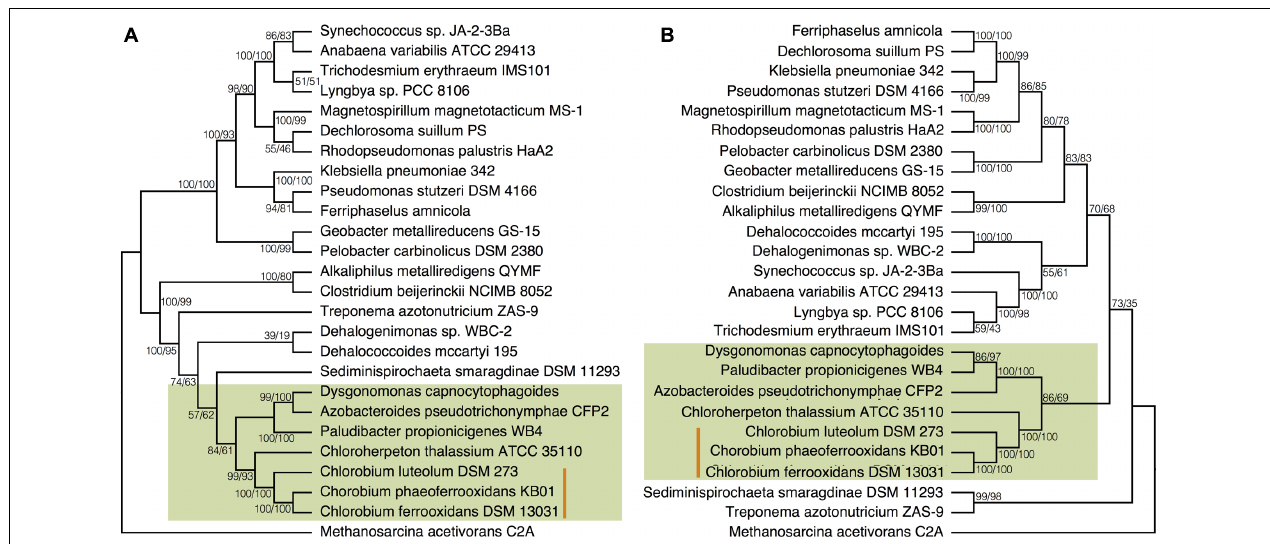
FIGURE 4 | Phylogenies of (A) the concatenated NifDKH proteins and (B) 16S rRNA for two to four representatives of several nitrogen-fixing phyla with bootstrap values shown at each node (maximum likelihood/maximum parsimony). The green color delineates the Chlorobi/Bacteroidetes monophyletic grouping, while the orange line indicates the position of the photoferrotrophic Chlorobi. Note: Azobacteroides pseudotrichonymphae CFP2 is abbreviated from Candidatus Azobacteroides pseudotrichonymphae genomovar.